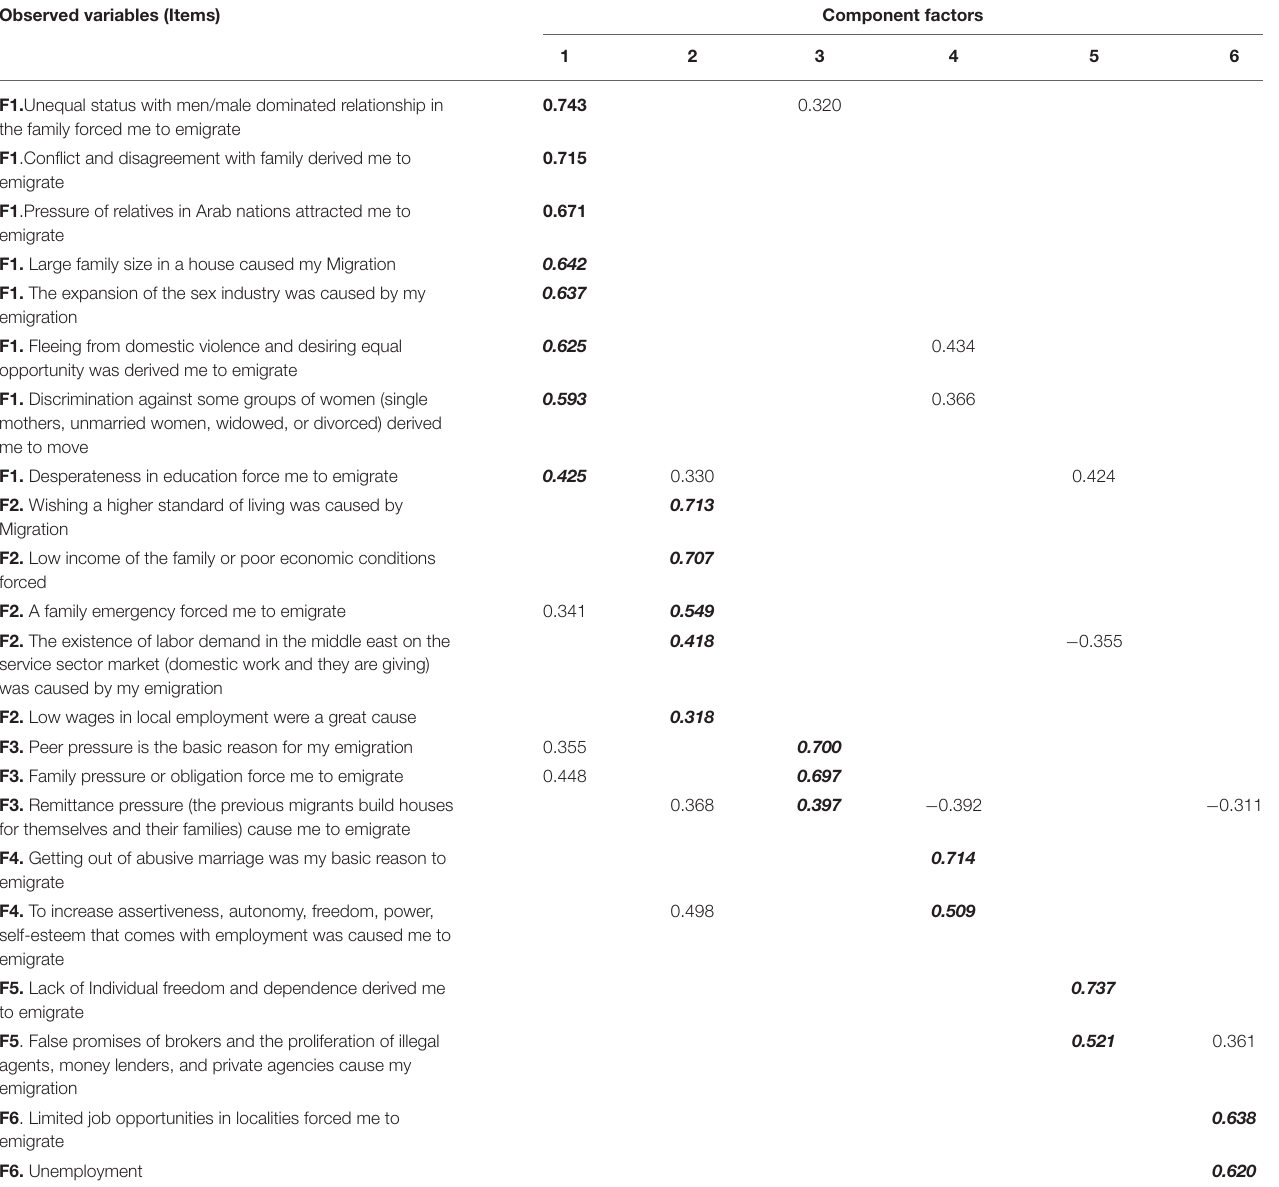
TABLE 7 | Extracted component factors with rotated component matrix a . Observed variables